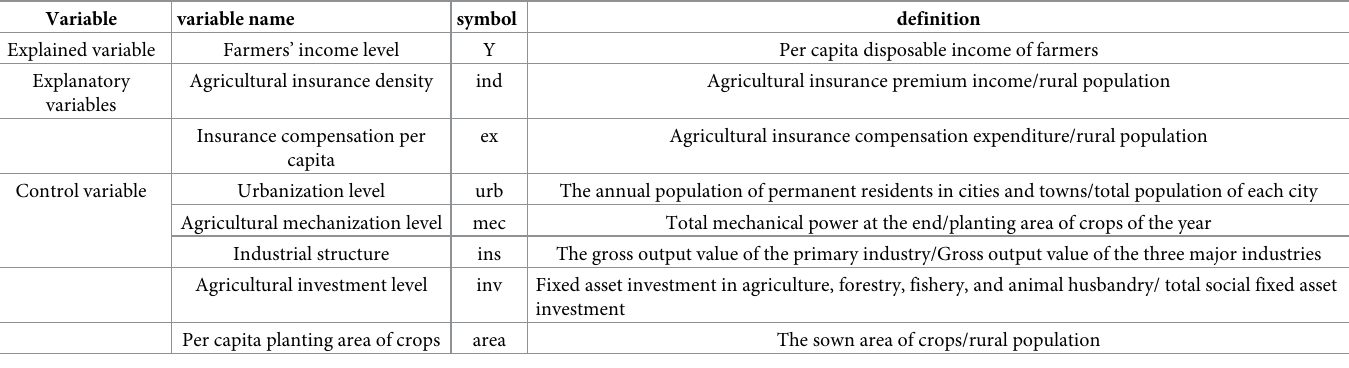
Table 2. Detailed explanation of each variable.